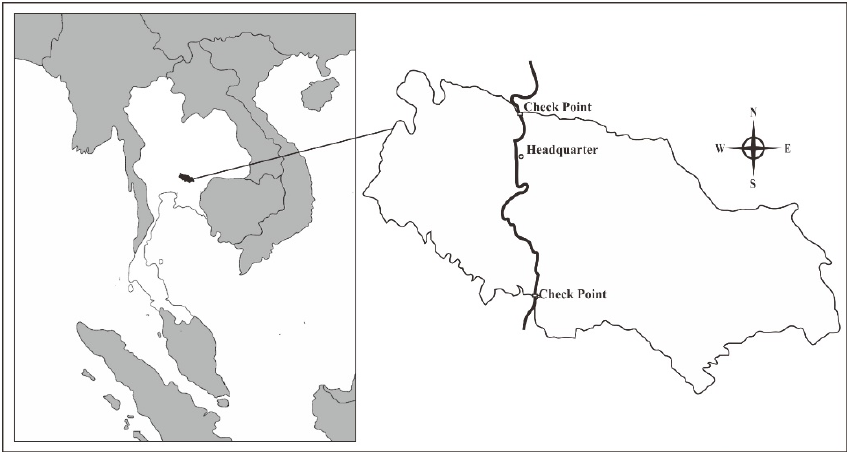
Figure 1. Location of Khao Yai National Park.